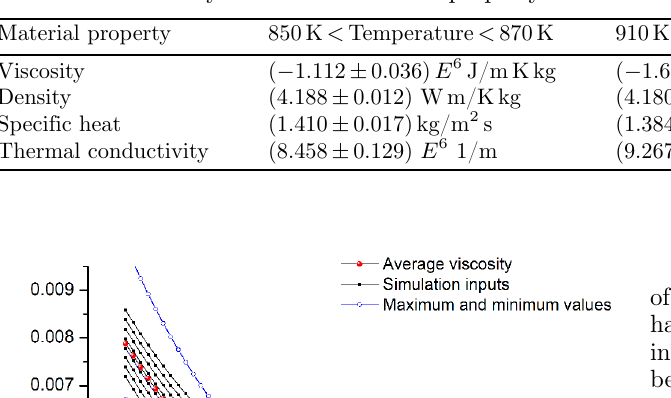
Table 6. Sensitivity coefficients for each property in different temperature ranges.